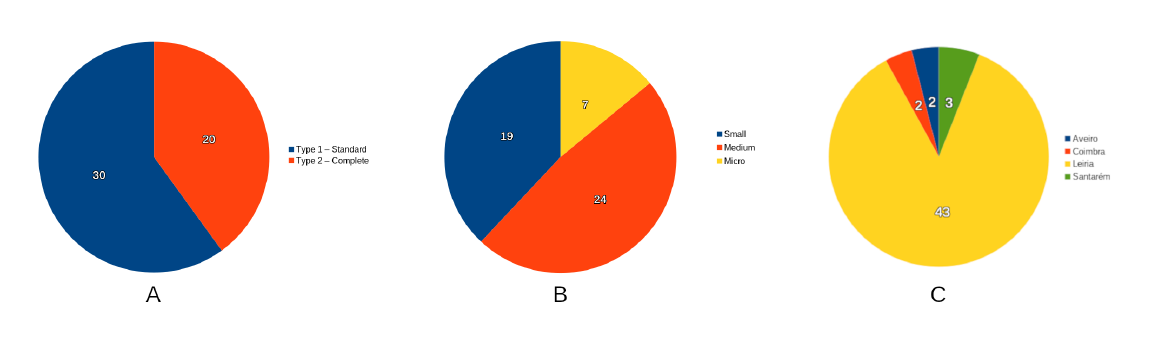
Figure 1. Characterization of the SMEs participating in the case study—( A ) Type of auditing (Type 1 and Type 2); ( B ) type of company: small, medium, and micro enterprise; and, ( C ) companies per